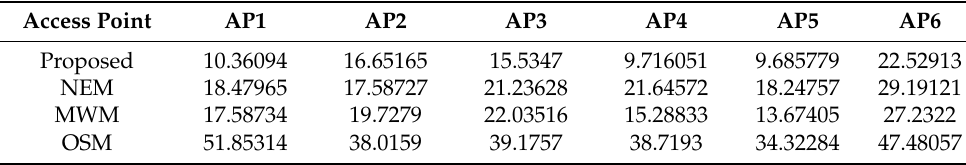
Figure 6. Prediction Errors. Respective AP’s average RSSI prediction comparison. Table 10. Average prediction errors evaluation.